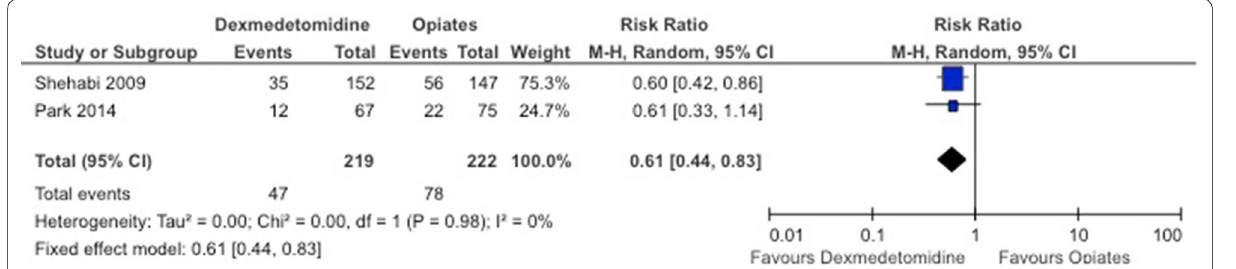
Fig. 4 Forest plot for incidence of delirium in opioid-controlled